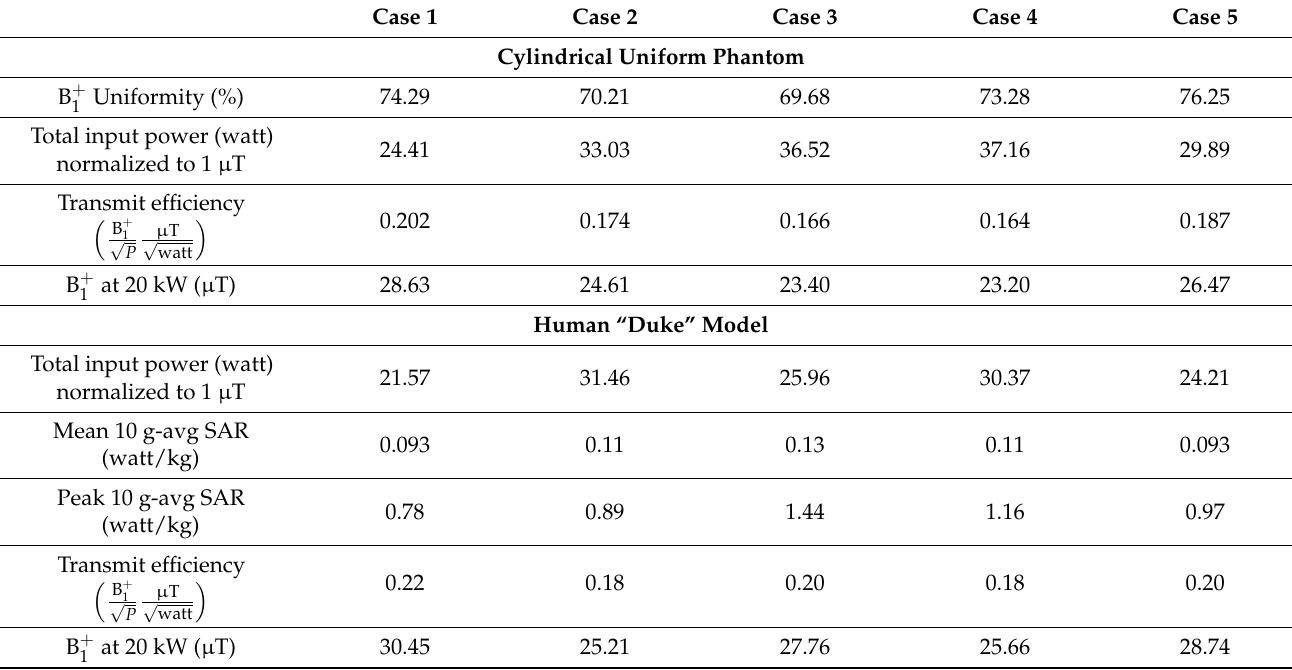
Table 2. Summary of uniformity, input power, transmit efficiency, and maximum B 1+ at 20 kW (most commercial MRI systems are equipped with 20 kW RF amplifier) in cylindrical uniform phantom; mean 10 g average SAR and peak 10 g average SAR in human “Duke” model for simulated RF coils in optimal driving mode, as shown in Figure 1.